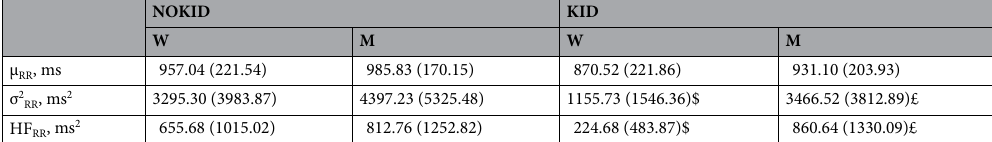
Table 6. Results of the cardiac autonomic profile comparison between working women and men in relation to the presence of preschoolers during NIGHT. DAY, daytime; KID, children in preschool age; NOKID, no children in preschool age; W, women; M, men; RR, RR interval; μ RR , mean RR; σ 2 RR , variance of RR; HF, high frequency; HF RR , power of RR series in the HF band. Results are presented as median. In bracket the interquartile range, calculated as the difference between the first and the third quartile is presented. $ indicates p < 0.05 KID versus NOKID; £ indicates p < 0.05 M versus W.